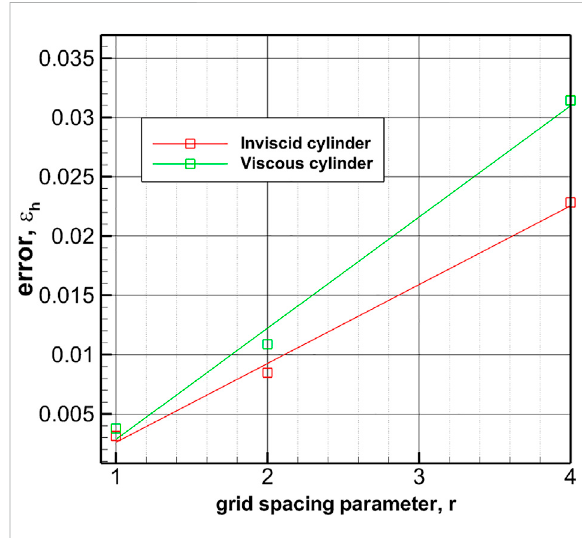
FIGURE 22 Variation of ϵ with an average grid spacing parameter (r) for the supersonic inviscid fl ow past the cylinder (red) and the viscous fl ow past the cylinder